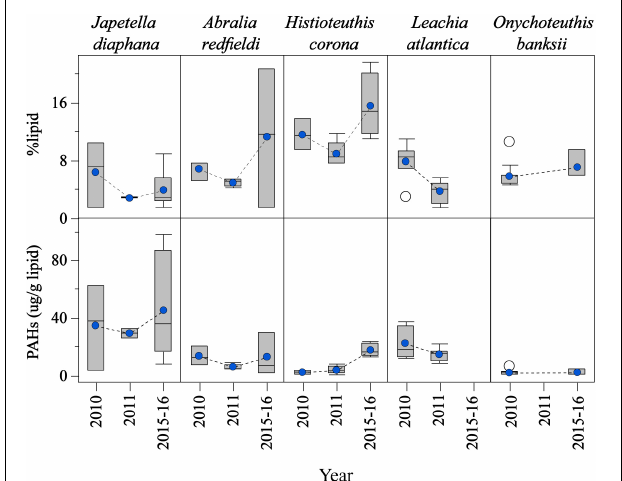
FIGURE 3 | Temporal variability of lipid contents and PAH concentrations in the mantle tissue of deep-sea cephalopod species collected in the northern Gulf of Mexico. Sampling years: pre-spill: 2010, and post-spill: 2011, and long-term: 2015–2016. PAHs refer to the sum of 2–6 ring including alkylated homologs. Graph shows shaded boxes as the interquartile ranges, with horizontal lines indicating median values and whiskers representing 10th and 90th percentile. Blue circles denote mean values, and white circles denote